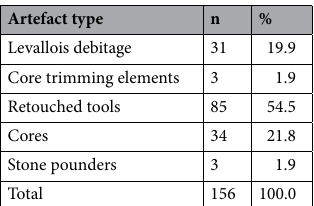
Table 1. General composition of Rockefeller Museum Shukbah Layer D